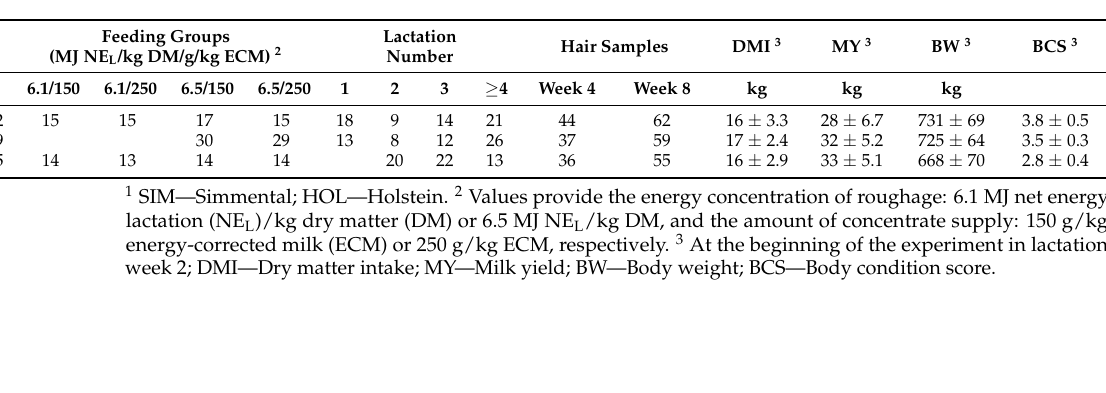
Table 1. Experimental setup: farms with breed, number of animals, assignments to feeding groups, lactation number, and number of hair samples in weeks 4 and